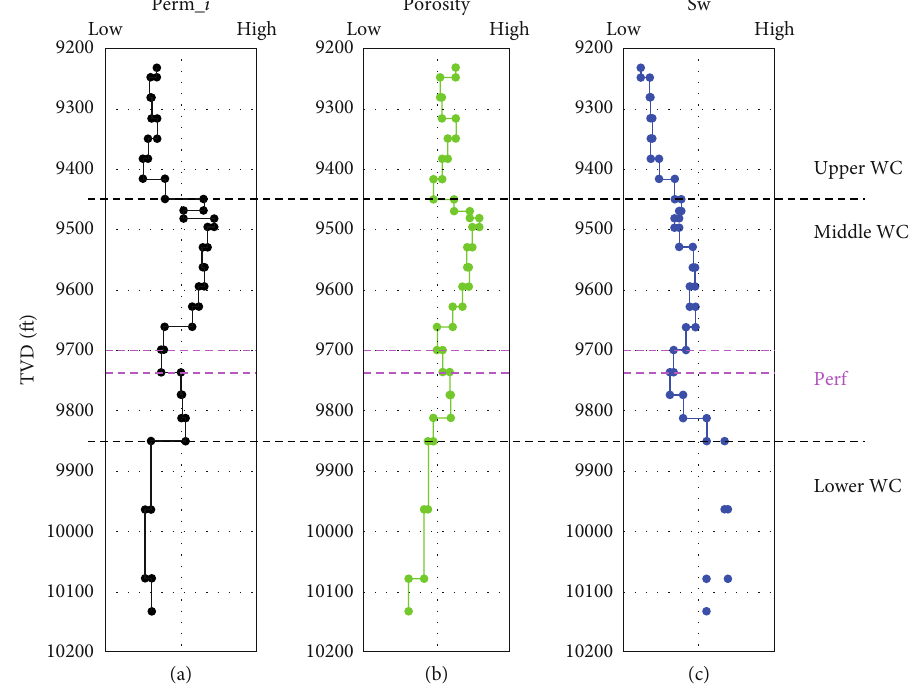
Figure 5: Property variation along depth: (a) permeability in the i -direction, (b) porosity, and (c) water